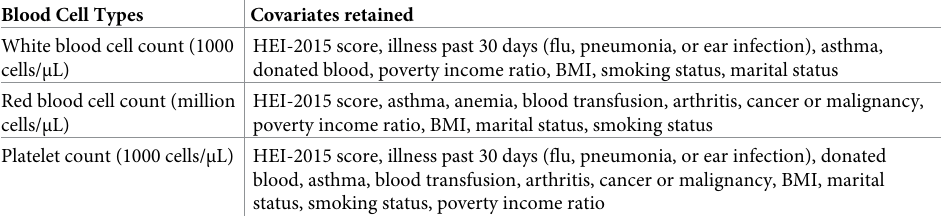
Table 1. Covariates retained through backward elimination in fully adjusted models. Blood Cell